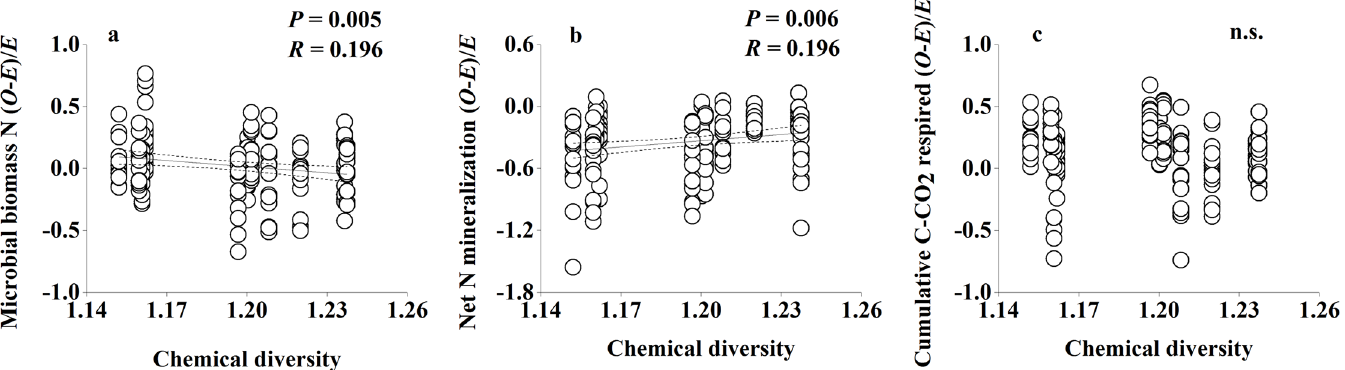
Fig 3. Non-additive soil microbial biomass N (a), soil net N mineralization (b) and cumulative soil respiration (c) responses to litter mixtures as a function of chemical diversity ( H c ) of litter mixtures. Dashedlines represent the 95% confidenceintervalof the regression. O : observed values; E : expected values. n.s.: not